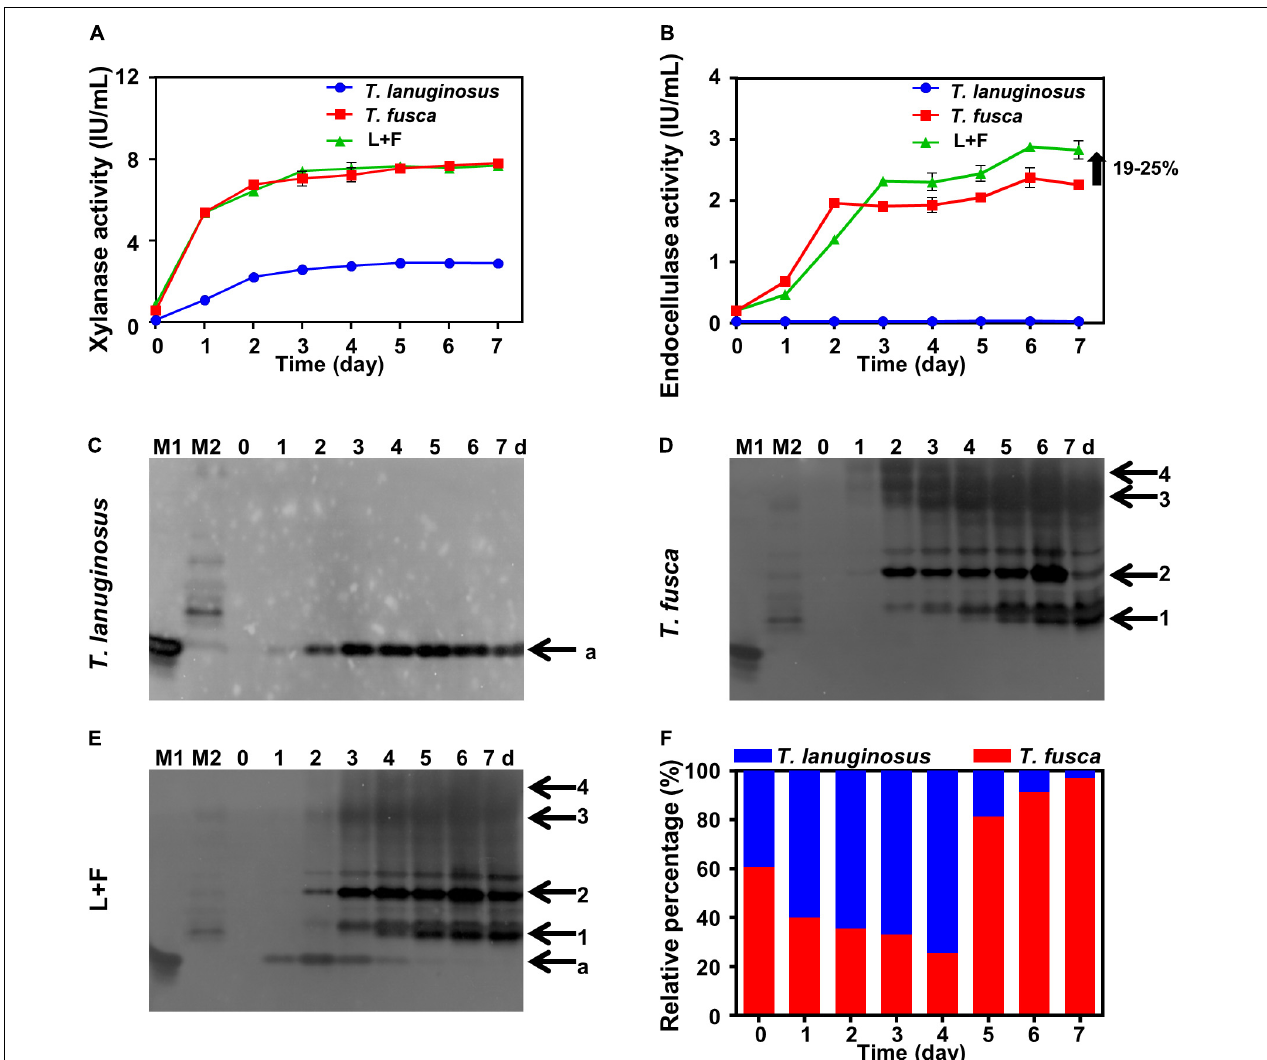
FIGURE 2 | Thermomyces lanuginosus and T. fusca were cultured alone or cocultured in 1% (w/v) corn stalk liquid medium (A–F) for 7 days. (A) Xylanase activity of the crude enzymes. (B) Endocellulase activity of the crude enzymes. (C–E) Xylanase native zymogram characterizing the xylanase secretion of T. lanuginosus or/and T. fusca . (F) Relative gene content of ITS and 16S rDNA representing the relative biomass of T. lanuginosus and T. fusca . T. lanuginosus represents the monoculture of T. lanuginosus . T. fusca represents the monoculture of T. fusca . L+F represents the coculture of T. lanuginosus and T. fusca . M1 and M2 represent markers of T. lanuginosus and T. fusca , respectively. Band “ a ” represents band of xylanase secreted by T. lanuginosus . Bands “ 1–4 ” represent bands of xylanases secreted by T. fusca .